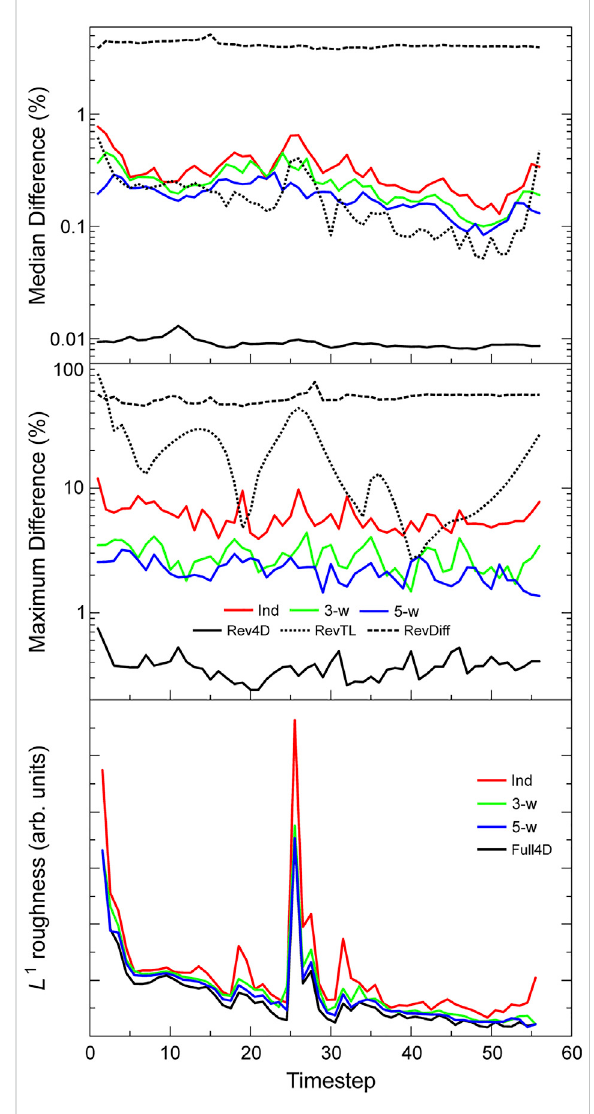
FIGURE 5 Quantitative measures of consistency for each of the inversion methods. Top: median differences between the forward full sequence 4D inversion and the independent, windowed and reverse full sequence 4D inversions, and between the forward and reverse time-lapse inversions, and between the forward and reverse difference inversions. Middle: respective maximum differences. Bottom: L 1 measures of the temporal roughness of the independent, windowed and full sequence 4D inversions.